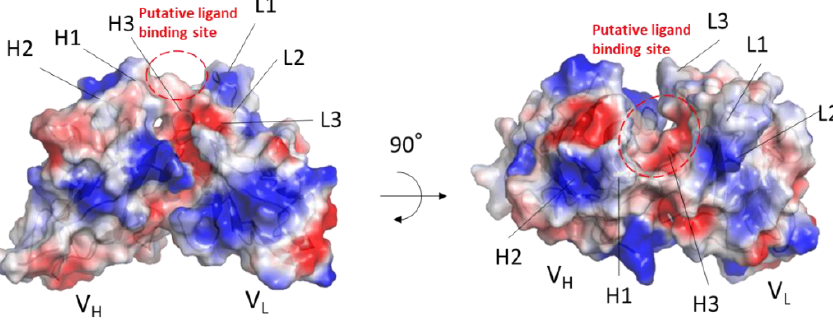
Figure 8. Electrostatic surface potential of MY.1E12 Fv domain. The surface model of MY.1E12 Fv is colored according to the electrostatic surface potential (blue, positive; red, negative; scale from −50 to +50 kT/e). Putative ligand-binding areas are circled with red dotted line. Figures were prepared using PyMol software.